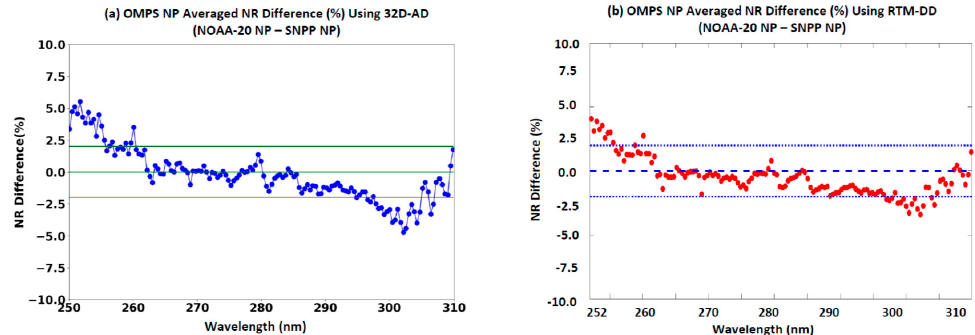
Figure 14. Comparison of the averaged NP inter-sensor calibration radiometric biases at all NP channels between SNPP and NOAA-20 using the 32D-AD method and TomRad-DD, where the data cover the period from 31 December 2020, to 31 January 2021, over a 32-day period. The dashed